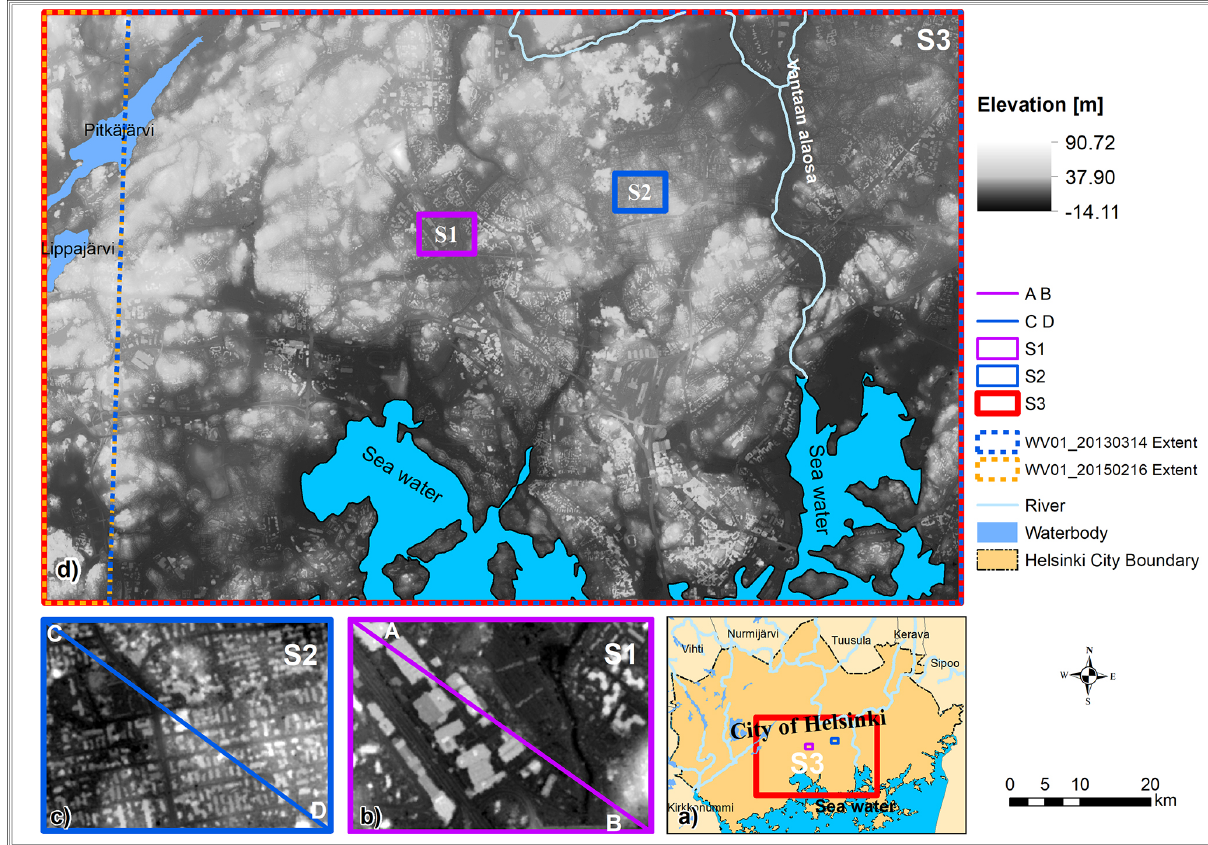
Figure 1. Locations of the three studied samples (S1, S2, and S3) within the city of Helsinki are shown in (a) . Elevation values of the ArcticDEM at S1, S2 (overlain with transects crossing), and S3 are shown in (b–d) , respectively. Locations of coastal areas, lakes, and rivers are also labelled. The ArcticDEM strip data are acquired from the Polar Geospatial Center at https://data.pgc.umn.edu/elev/dem/setsm/ ArcticDEM/mosaic/v3.0/2m/ (last access: 26 January 2023). The waterbody outlines were acquired from the Finnish Environment Institute at https://wwwd3.ymparisto.fi/d3/gis_data/spesific/VHSvesimuodostumat2016.zip (last access: 26 January